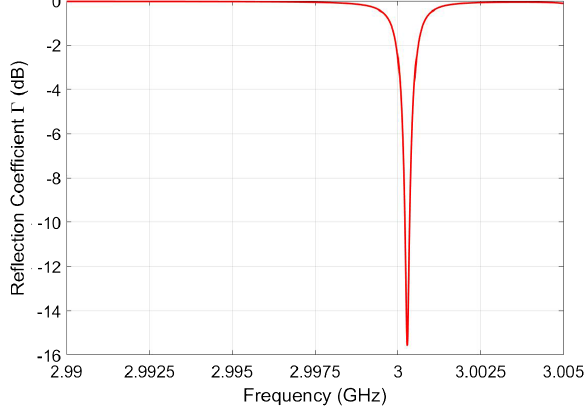
FIG. 8. Beam energy gain from z ¼ 0 cm (linac input) to z ¼ 67 cm (linac output). The final energy is 7 MeV.